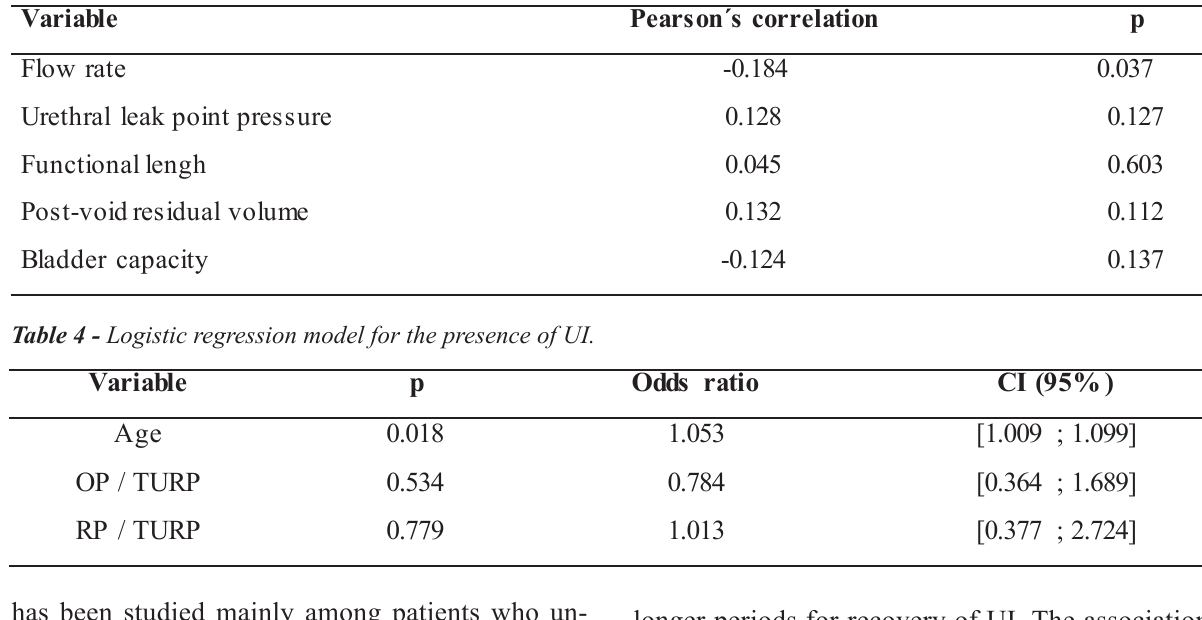
Table 3 - Correlation coefficients of patient age with urodynamic parameters.